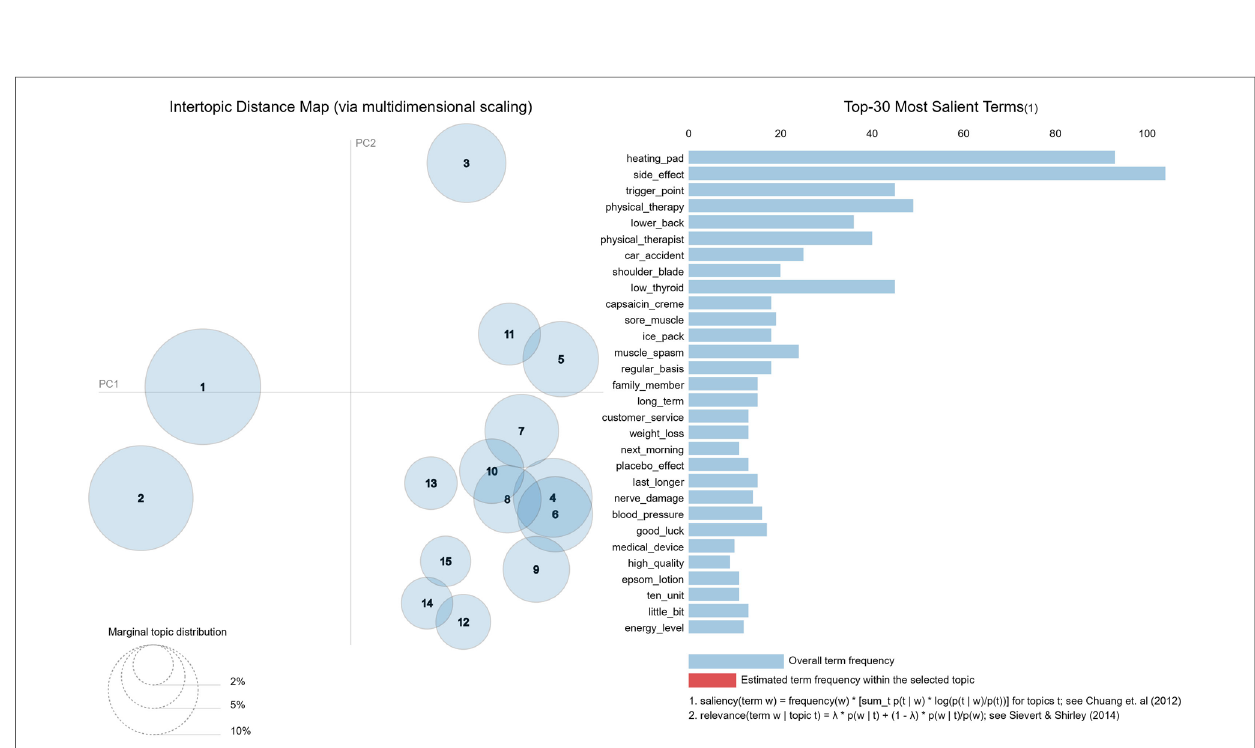
FIGURE 7 LDAviz result of the 15 topics with an inter-topic distance map and the top 30 most salient terms of the entire corpus. The circles in the left panel represent the sizes (prevalence) of the topics and their relative semantic distance from each other. The saliency bar chart in the right panel simply corresponds to term frequency in the corpus. The relative salient terms of each topic will update in the right panel upon clicking the speci fi c circle on the left (the interactive feature is not presented